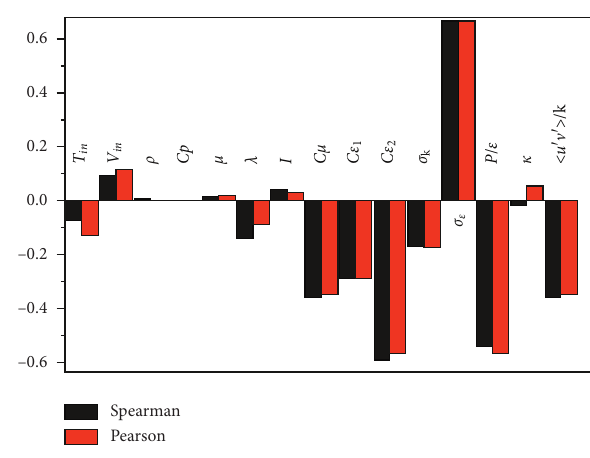
Figure 8: Correlation coefficients of Xr